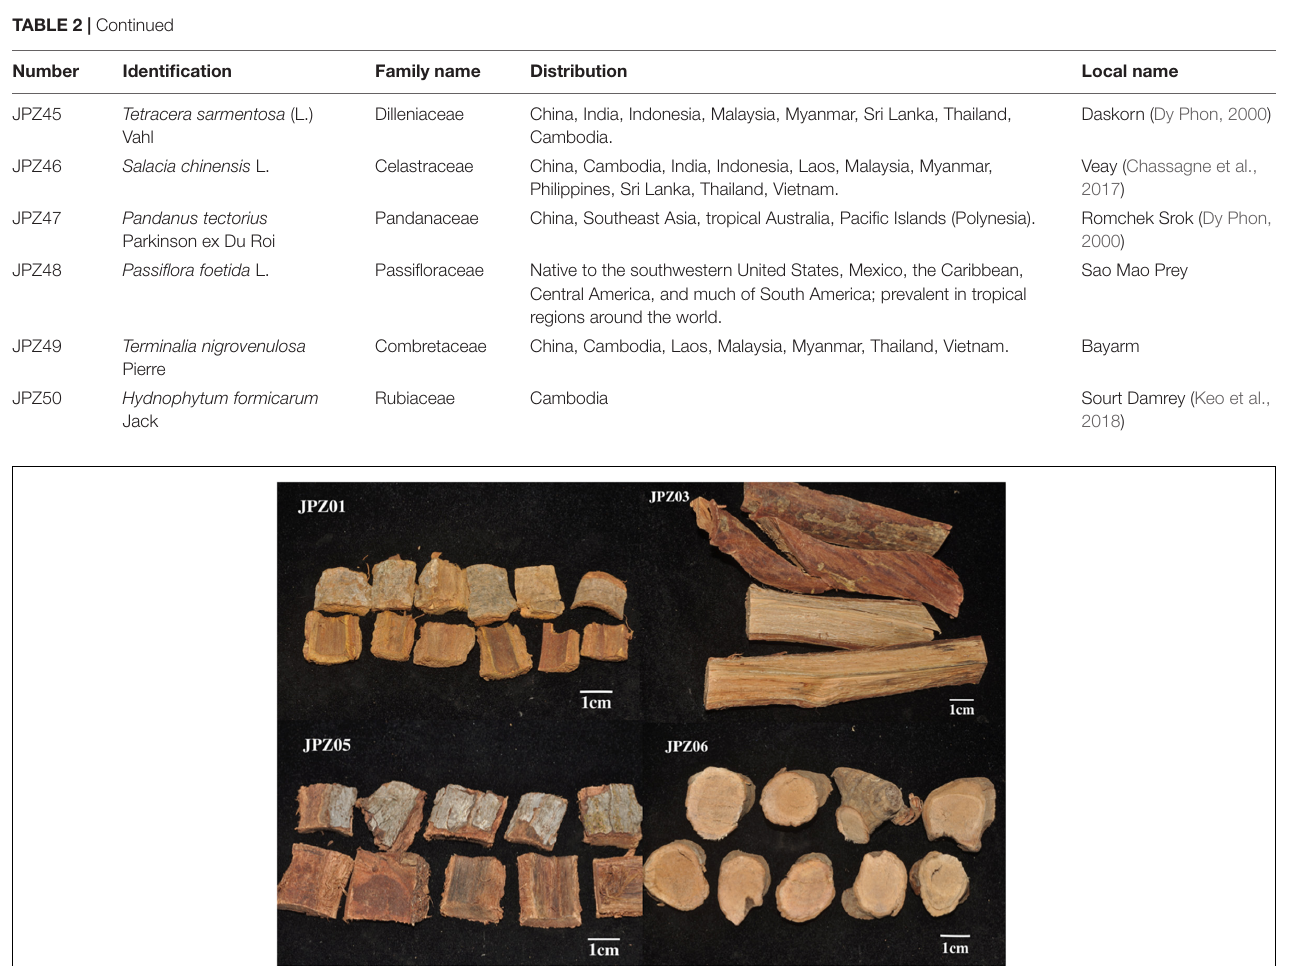
FIGURE 2 | Representative medicinal herbs obtained from a domestic market.